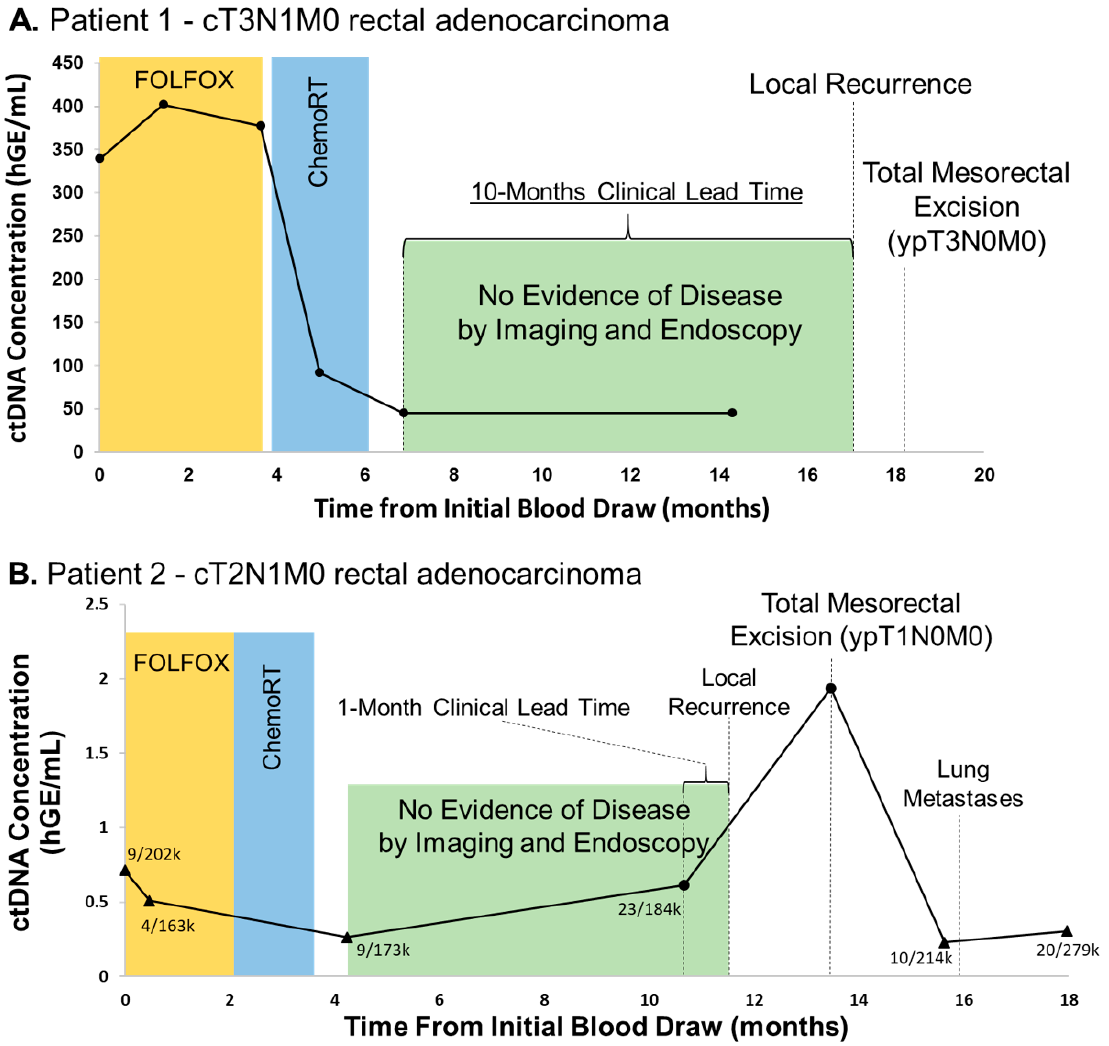
Figure 2. Rectal cancer patients with detectable post-treatment ctDNA eventually had local recurrence. Serial ctDNA levels were retrospectively analyzed using DIDA-Seq and using patient-specific capture panels. Aggregate variant allele frequency (VAF) was converted to human genome equivalents per ml (hGE/mL) of plasma and plotted over treatment course. ( A ) A 28-site capture panel was used for Patient 1 and ( B ) a 35-site capture panel was used for Patient 2. Statistical significance, as compared to a negative control, was determined at each time point. CtDNA values not significantly different from negative controls are indicated (triangle) and aggregate mutant reads/total reads are reported. Statistical significance was determined prior to converting aggregate VAF to hGE/mL plasma.